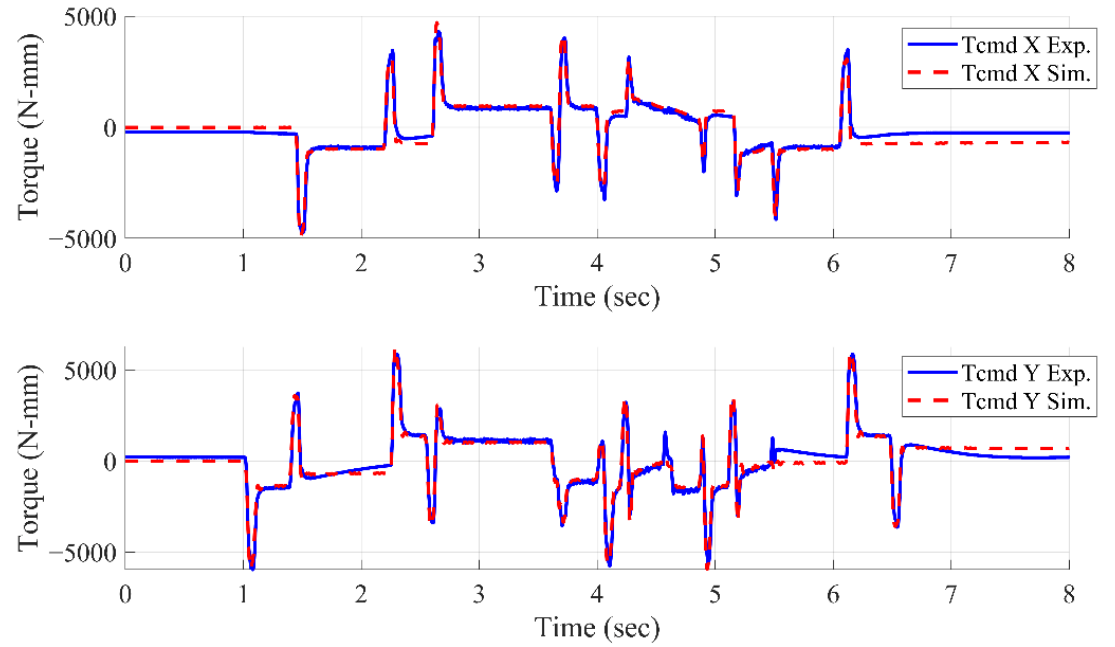
Figure 18. Comparison between measured and simulation torque.